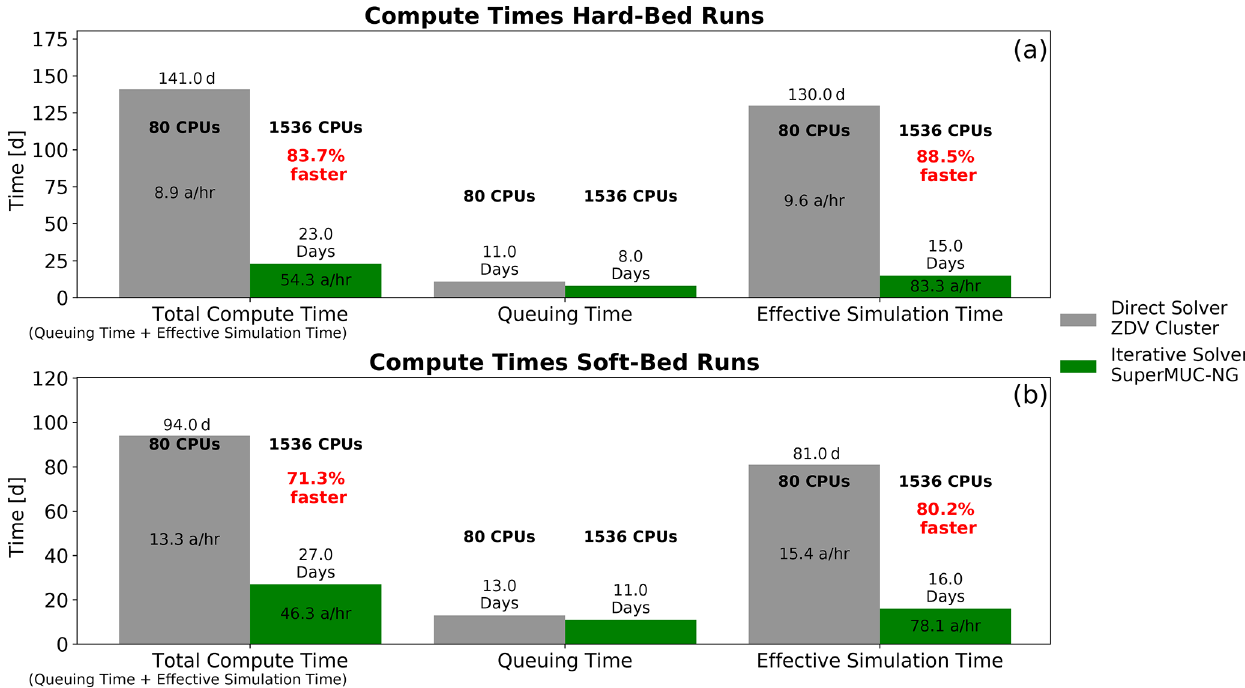
Figure 4. Speed-up of iterative solver (ParStokes, green bars) in comparison to direct solver (MUMPS, grey bars) for the hard-bed cavity (a) and soft-bed cavity (b) simulations. Simulations were performed on two different high-performance computing systems (ZDV and SuperMUC-NG).